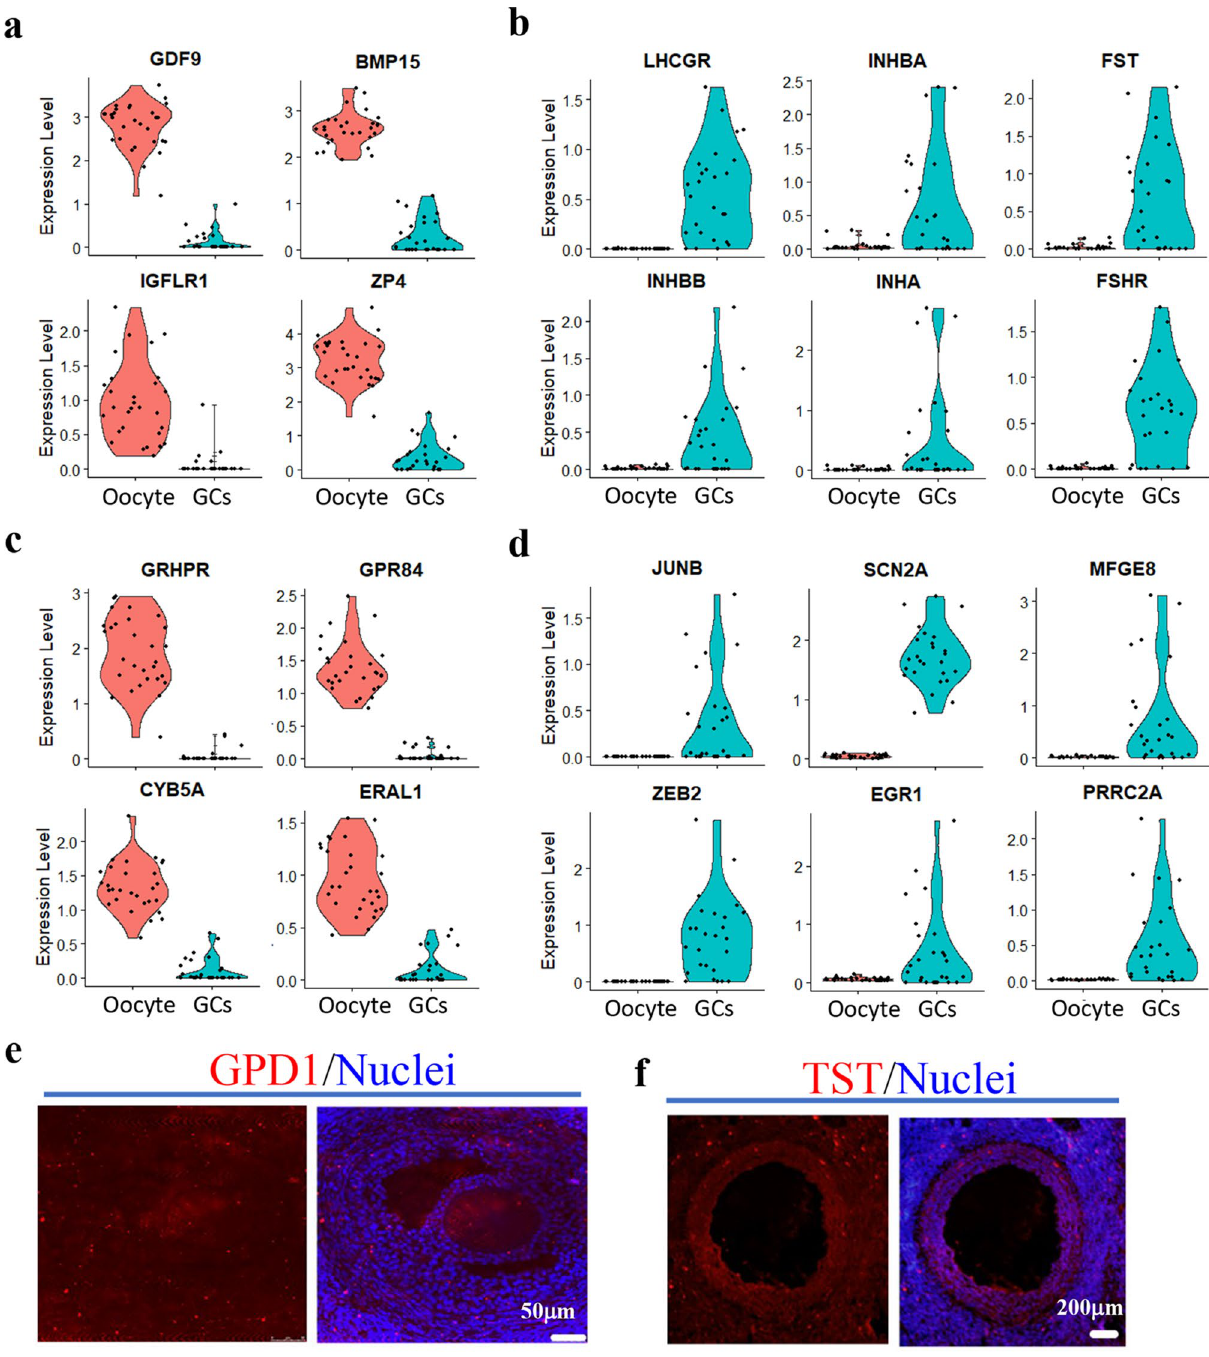
Figure 2. The molecular marker genes of oocytes and granulosa cells in Jining grey goat. ( a ) Typical marker genes in oocyte. ( b ) Typical marker genes in GCs. ( c ) Novel identified marker genes in oocytes. ( d ) Novel identified marker genes in GCs. ( e ) IHF for GPD1. ( f ) IHF for